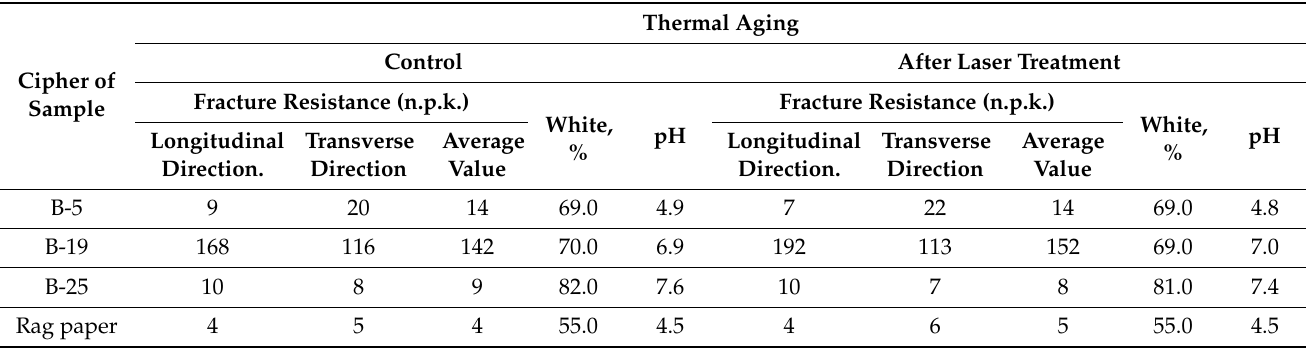
Table 4. Changes in the physical, mechanical, optical, and chemical properties of control paper samples and laser-treated paper samples after thermal aging (100 ◦ C, 72